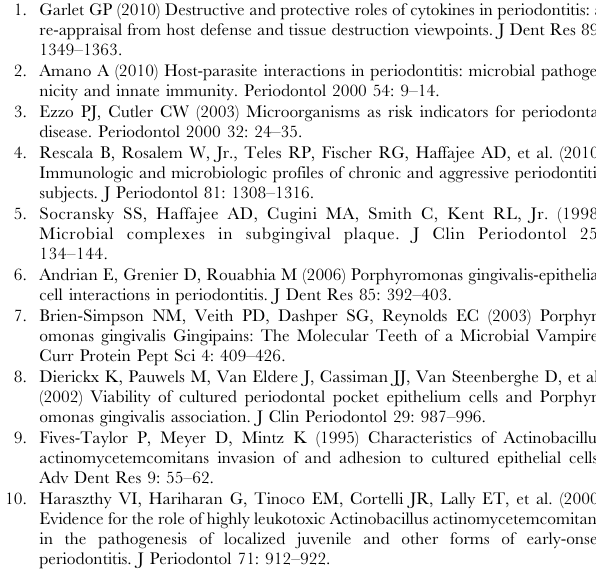
Figure S1 Thin-layer chromatography of MPLC-frac- tions. (PDF) Table S1 Retardation factor (Rf) of MPLC fractions determined by TLC analysis.